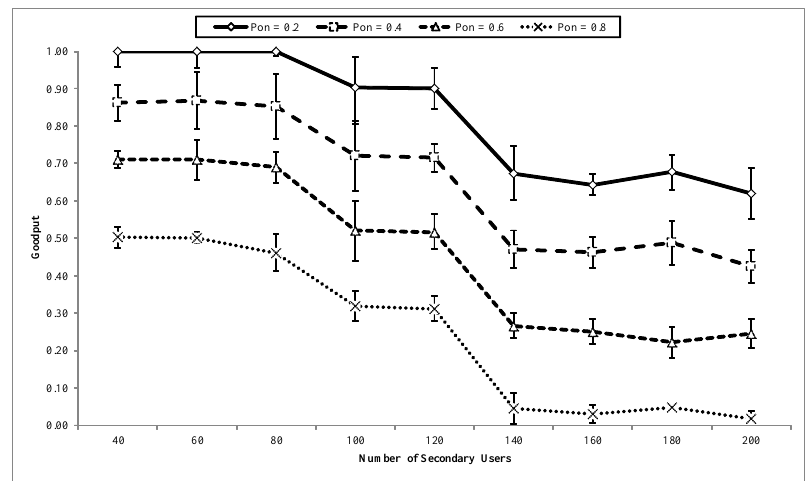
Figure 12. Goodput vs . number of CRSN nodes in the